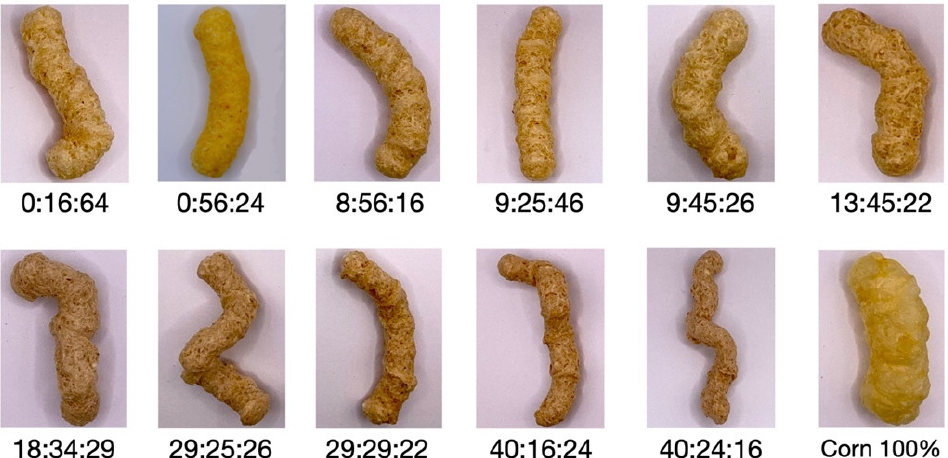
Figure 4. Extruded snacks with different proportions of flours (showing the ratios of okara: mung bean: rice) representing up to 80% of the formulation. One has corn as the only flour ingredient (100%). In the formulations with relatively low levels of okara (0–9%), increasing mung bean flour from 16 to 56% significantly increased the b* (yellower) value. The color is affected by the protein content, test color, pigment, flavonoids, etc., of the grains. In mung bean flour, ref. [40] found that L*, which represents brightness, was negatively correlated with ash content and was further affected by protein and damaged starch content. Changes in b* value, on the other hand, were related to native pigments such as uranidin, brown pigment, and flavonoids. Differences in the color index might also be caused by factors such as the degree of dispersion of the bean powder or the shape of the particles [41].